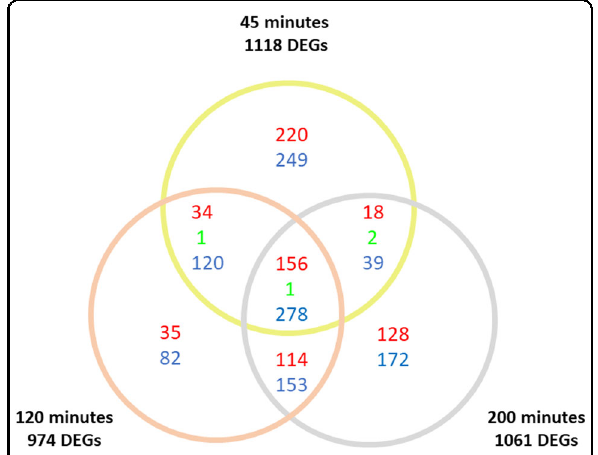
Fig. 1 Signi fi cant differential expressed genes number per exposure time. Total number of differentially expressed genes (DEGs) and Venn diagram with values at the three time points. In red number of upregulated genes, in blue number of downregulated gene, and in green number of contra-regulated